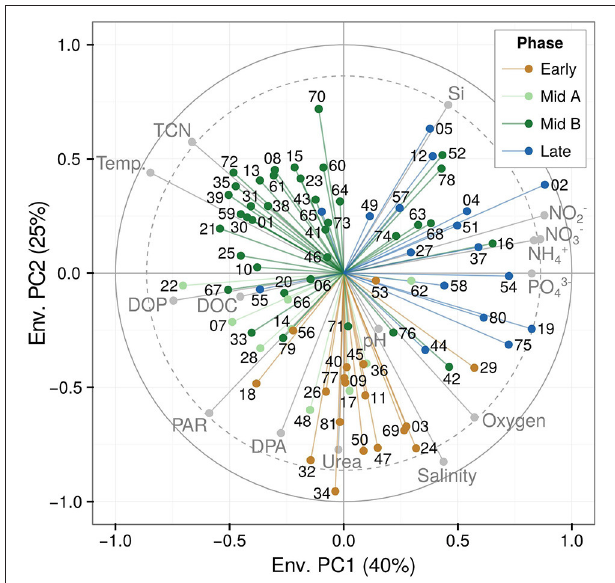
FIGURE 5 | Correlation of the 81 eigengenes (represented as component-specific colored points labeled with two-digit numbers) with environmental parameters (gray points; see Figure 1B ). The dashed ring marks particularly strong correlations (Pearson’s r = 0.86) with the critical significance threshold 0.05 (Bonferroni adjusted). DOC, dissolved organic carbon; DOP, dissolved organic phosphorus; DPA, dissolved primary amines; PAR, photosynthetic active radiation; TCN, total cell numbers. For the time course of each of the environmental parameters, see Figure 1B